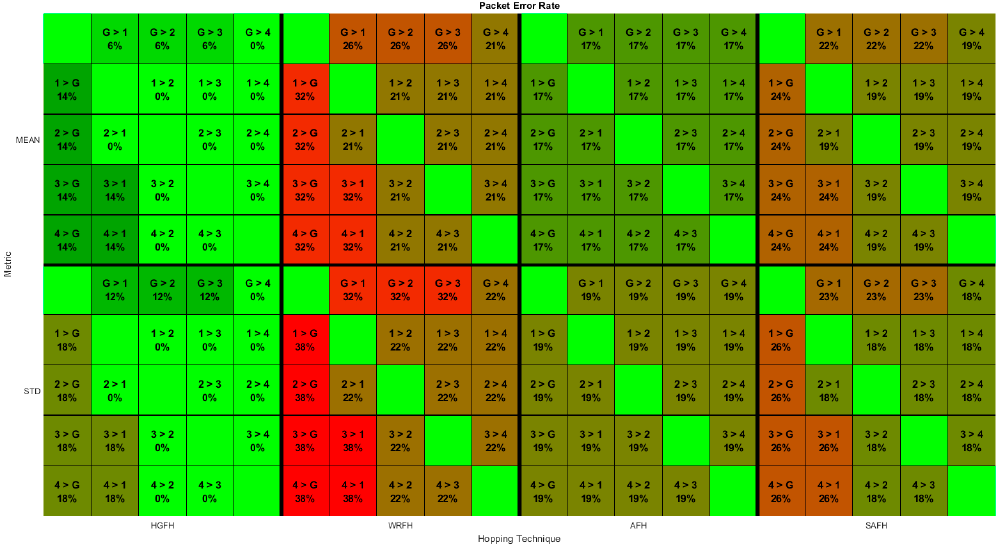
Figure 22. Packet Error Rate for all possible node connections for different quality metrics and hopping techniques. Each element contains the Packet Error Rate (PER) value (percentage) for the specified connection. 1 > (cid:1833) , for instance, indicates the connection from node 1 to the gateway. From the PER of each connection, the topology of the network can be determined in terms of overall packet error rate and transmission distances. Figure 23–Figure 25 show the resulting topologies when assigning different weights to the transmission distances and the resulting PER.